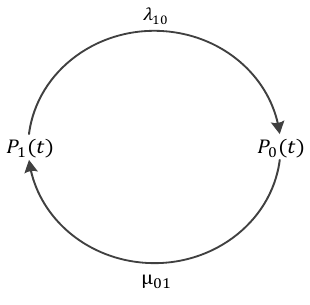
Figure 2. System transmission state.